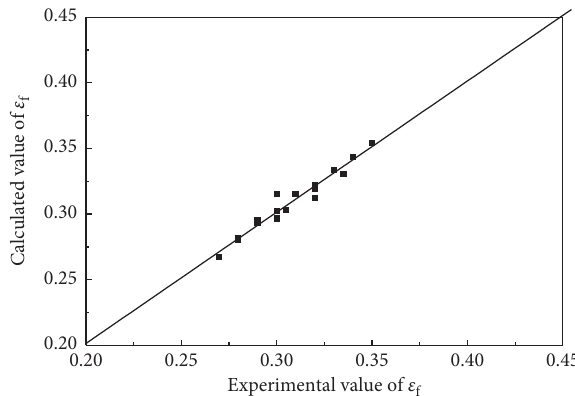
Figure 6: Comparison of the calculated critical fracture strain ε with experimental